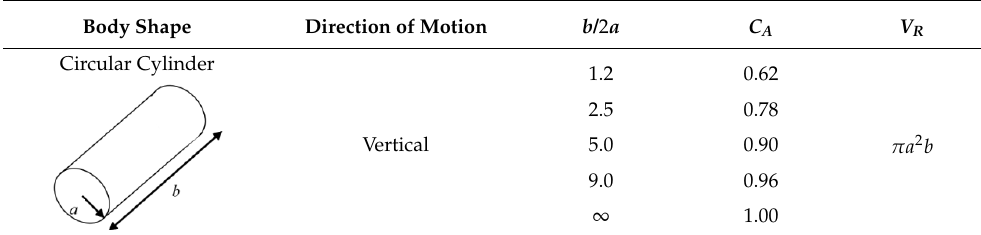
Table A1. Added mass data for the flow perpendicular to the circular cylinder (reproduced from [48] with permission from DNV, 2021).